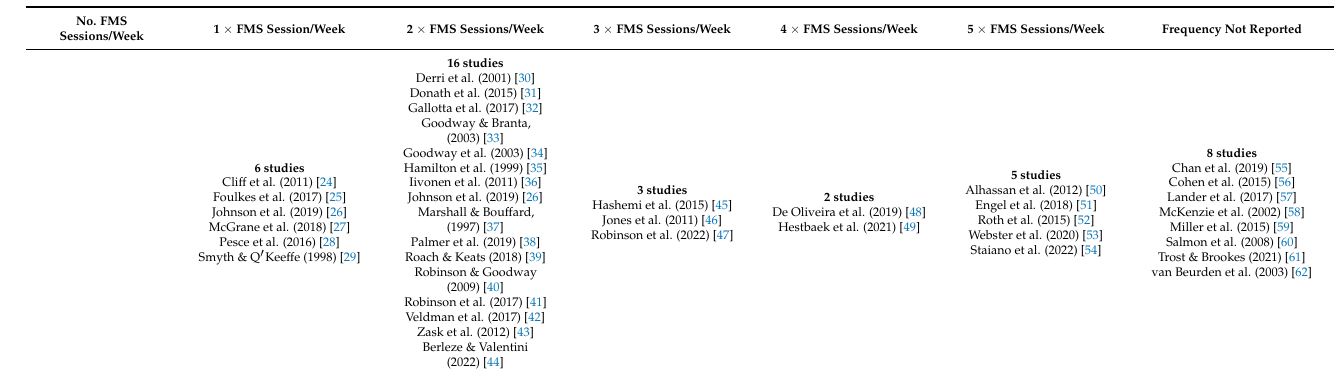
Table 1. The reported frequencies of FMS-related training sessions/interventions from randomized controlled trial evidence from 1997 to